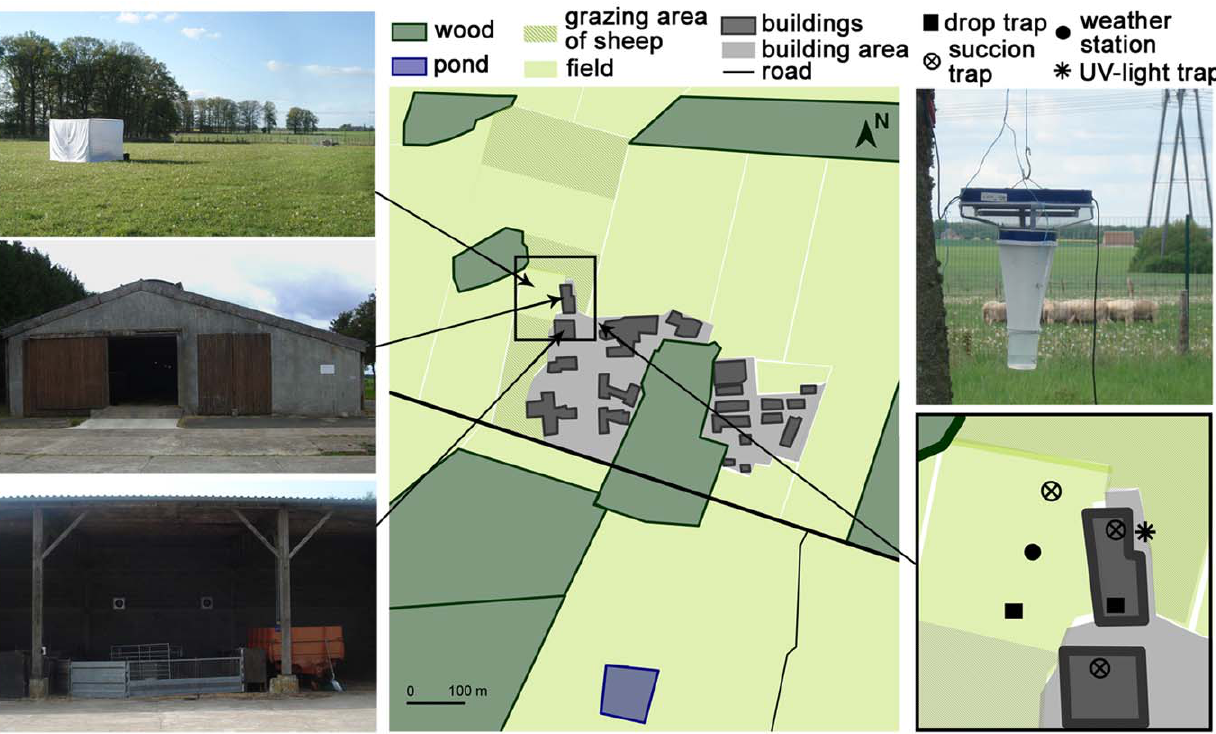
Figure 1. Climatic conditions in the study site. A. Ombrothermic diagram for comparison between 2010 and the 1971–2000 period (data from Me´te´o-France station of Parcay-Meslay); B. Boxplots of temperature ( u C) and relative humidity (%) recorded by data loggers at each location during the 15 collection sessions; C. Boxplots of mean and maximum wind speed (km/h) recorded by the local weather station during each of the 6 summer collections.